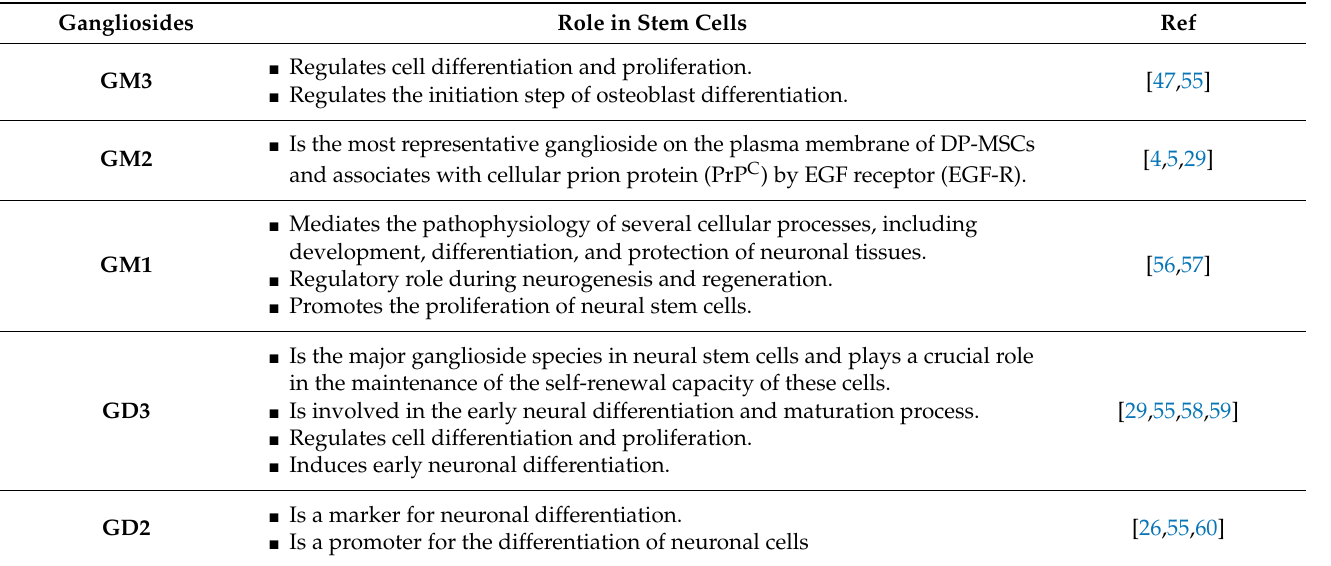
Table 1. Gangliosides and their role in stem